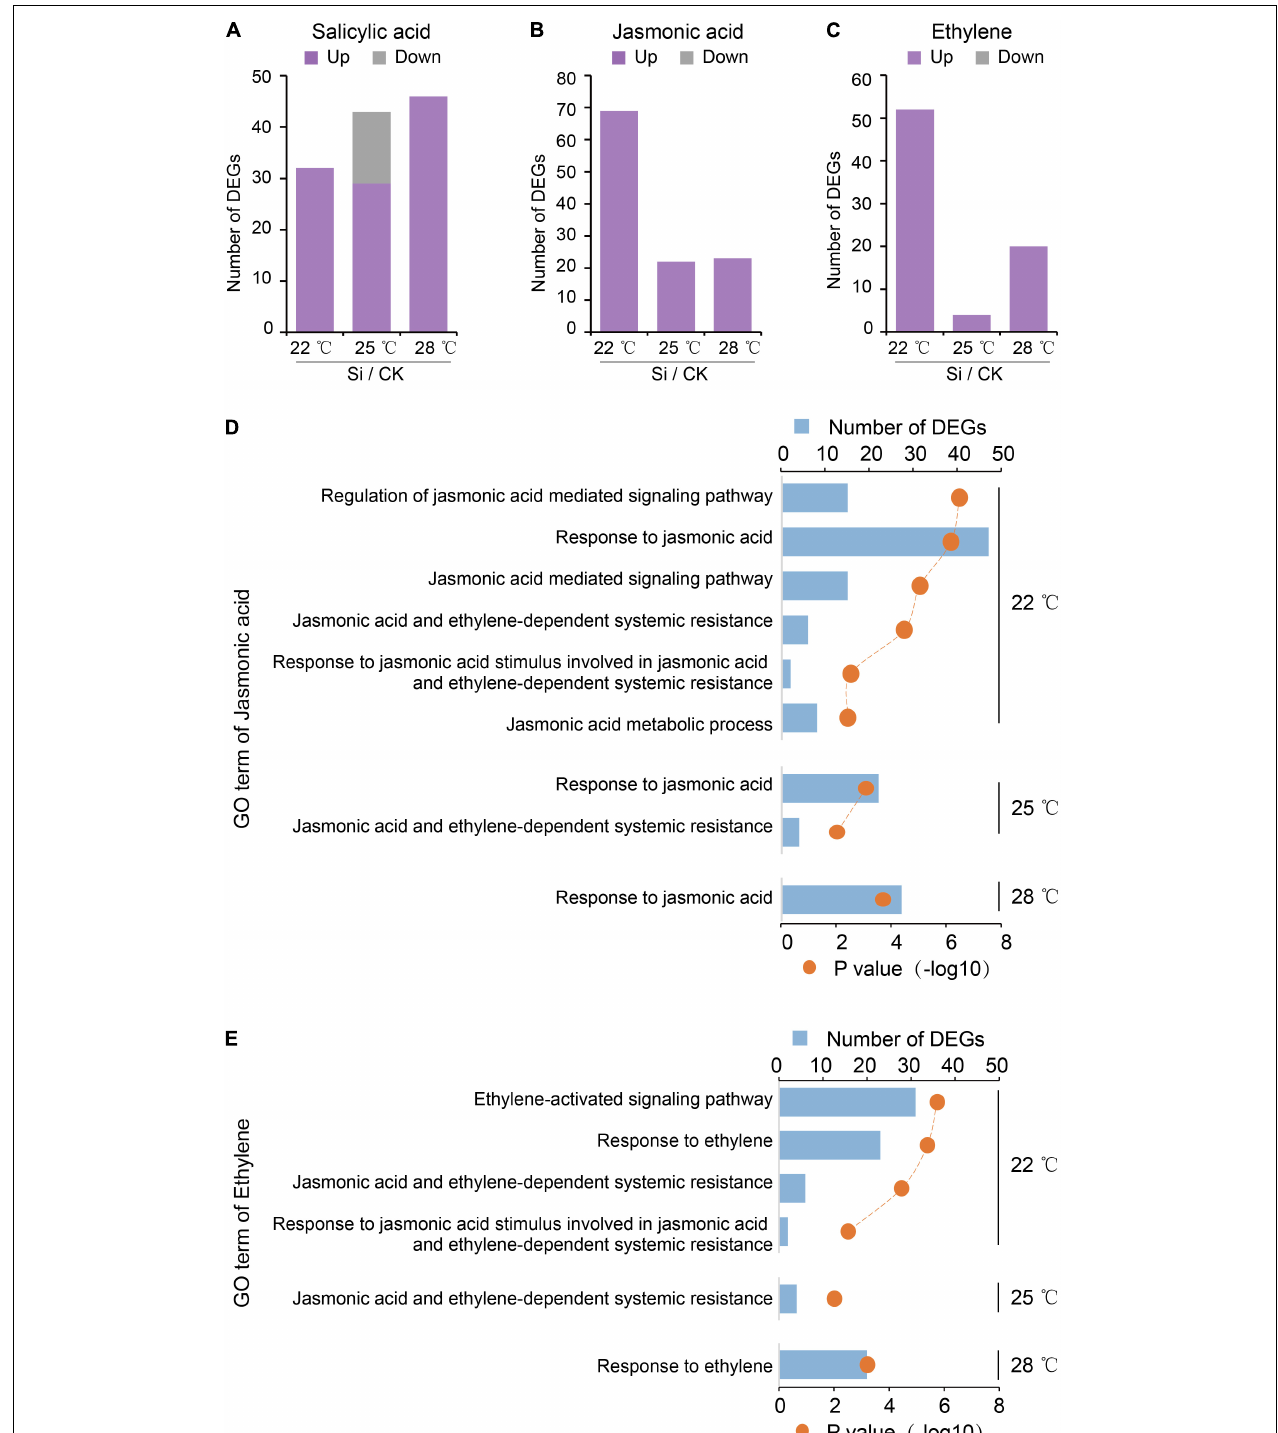
FIGURE 4 | High ambient temperature repressed plant JA and ET pathways during the systemic response. High temperature affected the number of DEGs between S. indica -incubated (Si) and control (CK) samples. (A) The number of DEGs of the salicylic acid (SA) pathway in Arabidopsis aboveground parts. (B,C) High ambient temperatures decreased the number of DEGs in the jasmonic acid (JA) and ethylene (ET) pathways. These DEGs were all upregulated DEGs. These results suggested that Arabidopsis JA and ET pathways induced by S. indica colonization are downregulated by elevated temperature. (D,E) GO analysis to the DEGs of JA and ET